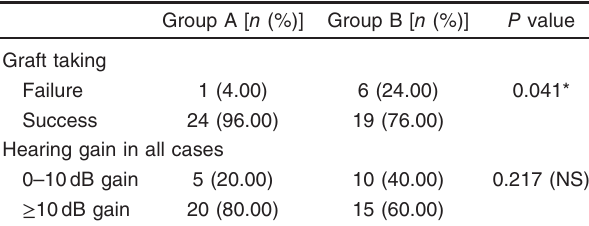
(10 patients) using a tragal cartilage graft, which